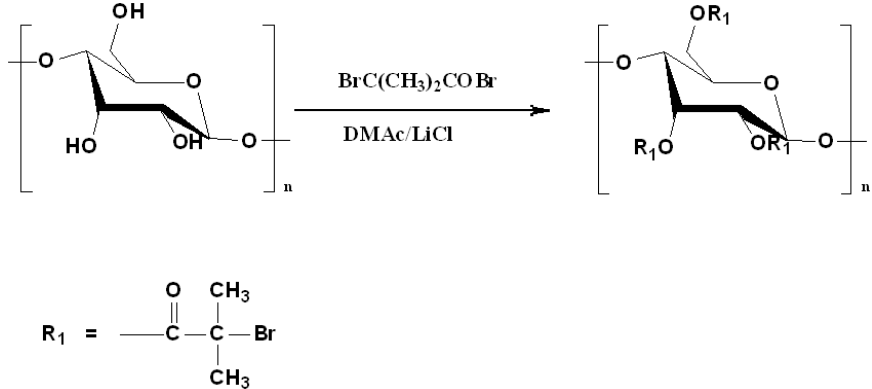
Figure 1. Synthesis of starch-based ATRP macroinitiator.